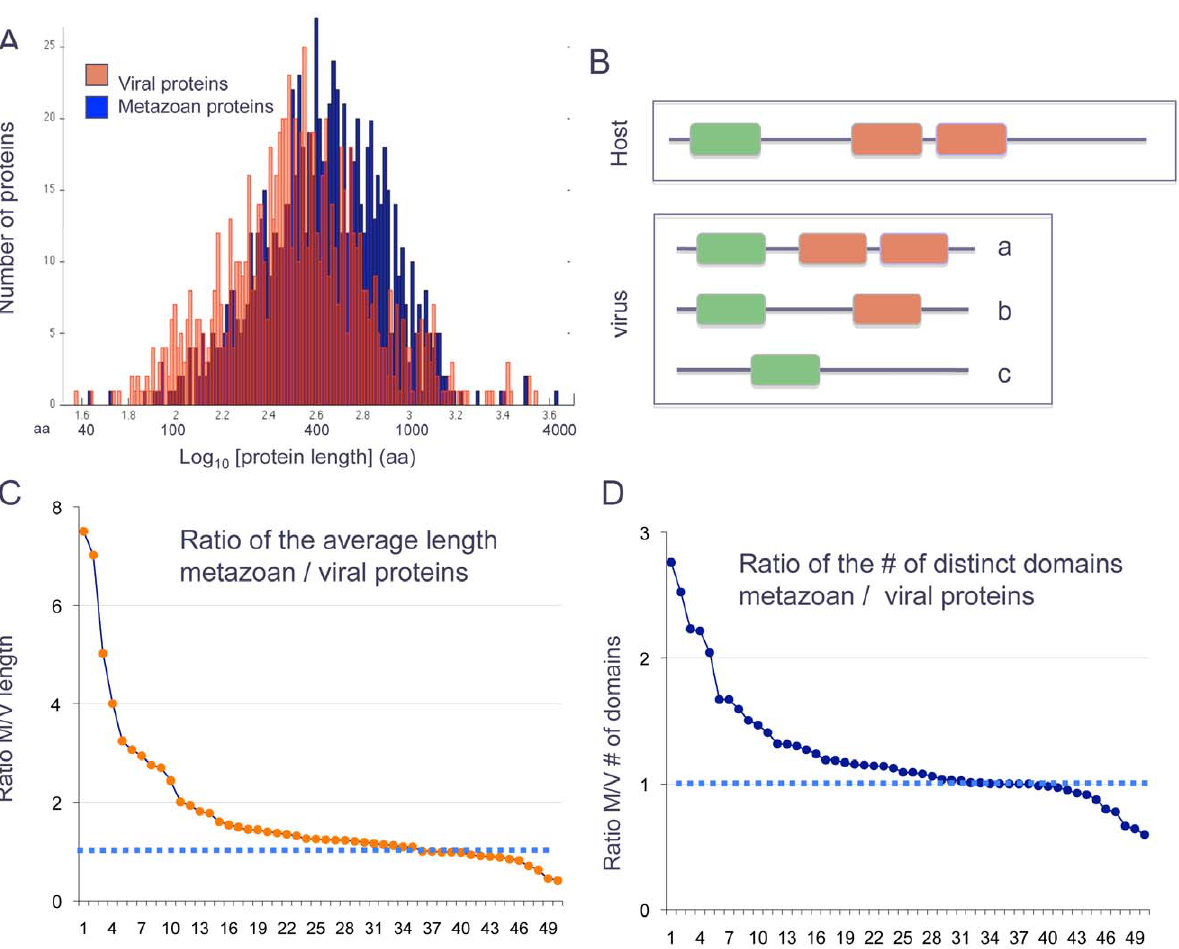
Figure 5. Length of proteins and Pfam domain properties of viral-metazoan proteins. ( A ) Analysis of the protein length distribution of viral (red) and metazoan proteins (blue) for the 667 Pfam based families. ( B ) A schematic view of multicellular proteins and possible variations. Changes in the viral protein length relative to the host related proteins in the same protein Pfam family could be due to a shortening of IDOL (inter- domain linkers) and the tail linkers (TAILs) (a); Additional scenarios are the elimination of a domain that is characterized by several appearances (b), and the elimination of multiple domains (c). ( C, D ) The results for 50 cross-taxa Pfam families that fulfill the following criteria: (i) at least 2 metazoan infected viral proteins, (ii) Pfam appearance is at least 3. The data points represent the proportion of the metazoan proteins’ length relative to the viral proteins’ length in each of the analyzed Pfam family ( C ), and the ratio of the number of the distinct Pfam domains in metazoan relative to the viral proteins ( D ). The horizontal broken line (reference line) in C and D marks no difference in the properties measured between metazoan and viral proteins (ratio of 1.0). M/V indicates metazoan/virus ratio.